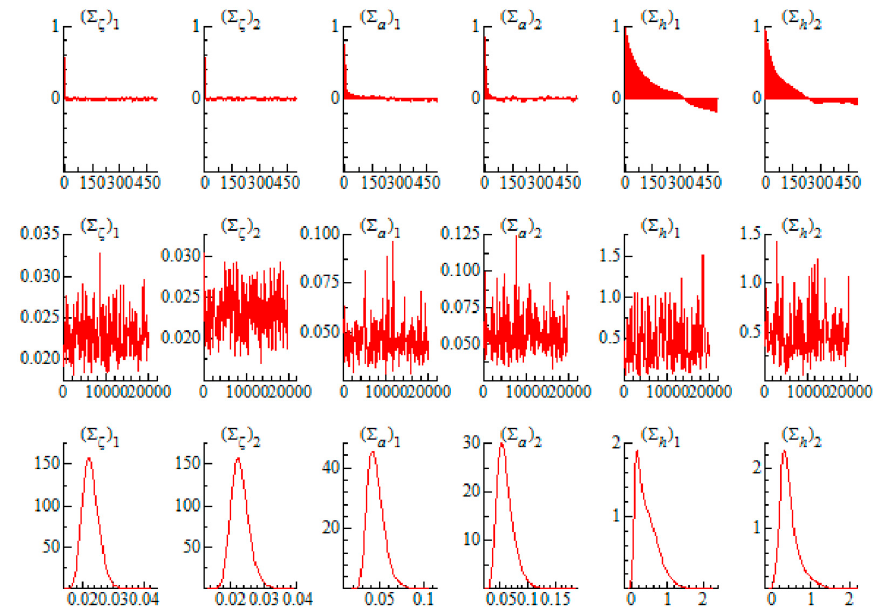
Figure 9. Estimation results of parameters in the TVP-VAR model (real estate development loans–housing prices). Notes: The figure shows sample auto-correlations ( top ), sample paths ( middle ), and posterior densities ( bottom ); in the top figures, the x -axis is the sample auto-correlation, and the y -axis is the lag; in the middle figures, the x -axis is the sampled value, and the y -axis is the iteration; in the bottom figures, the x -axis is the probability density, and the y -axis is the sampled value; the estimates of Σ ς and Σ a are multiplied by 100.